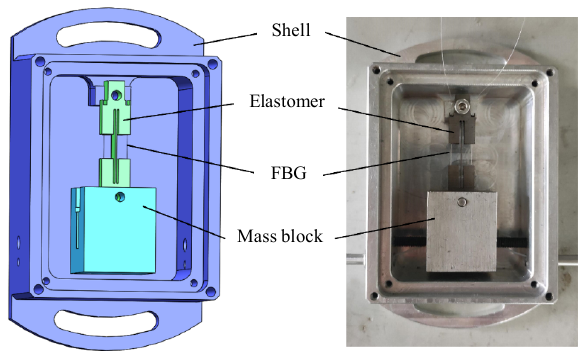
Fig. 1 Structure of the tilt